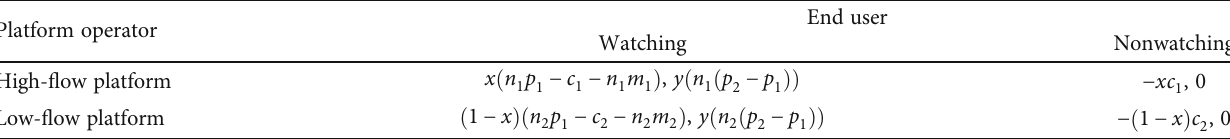
Table 6: Evolutionary game